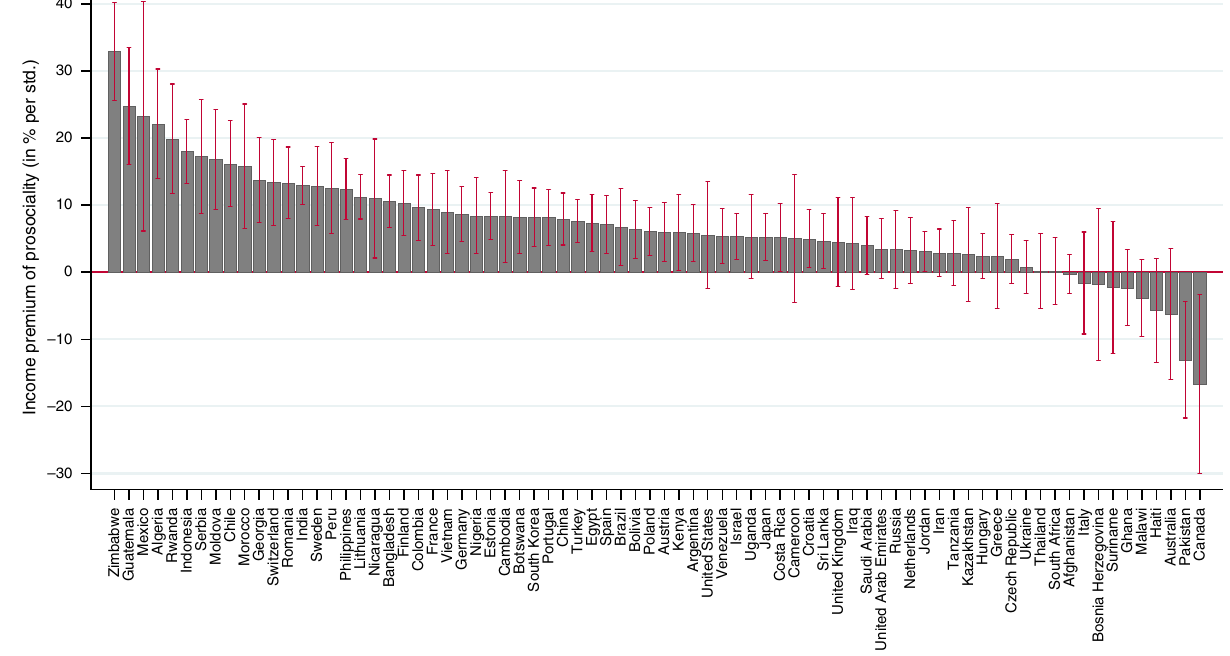
Fig. 1 Income premia of prosociality (in percent of household income) around the world. Displayed coef fi cients are country-speci fi c estimates of the model shown in Table 1, Panel A, column 2, error bars indicate 90% con fi dence intervals.